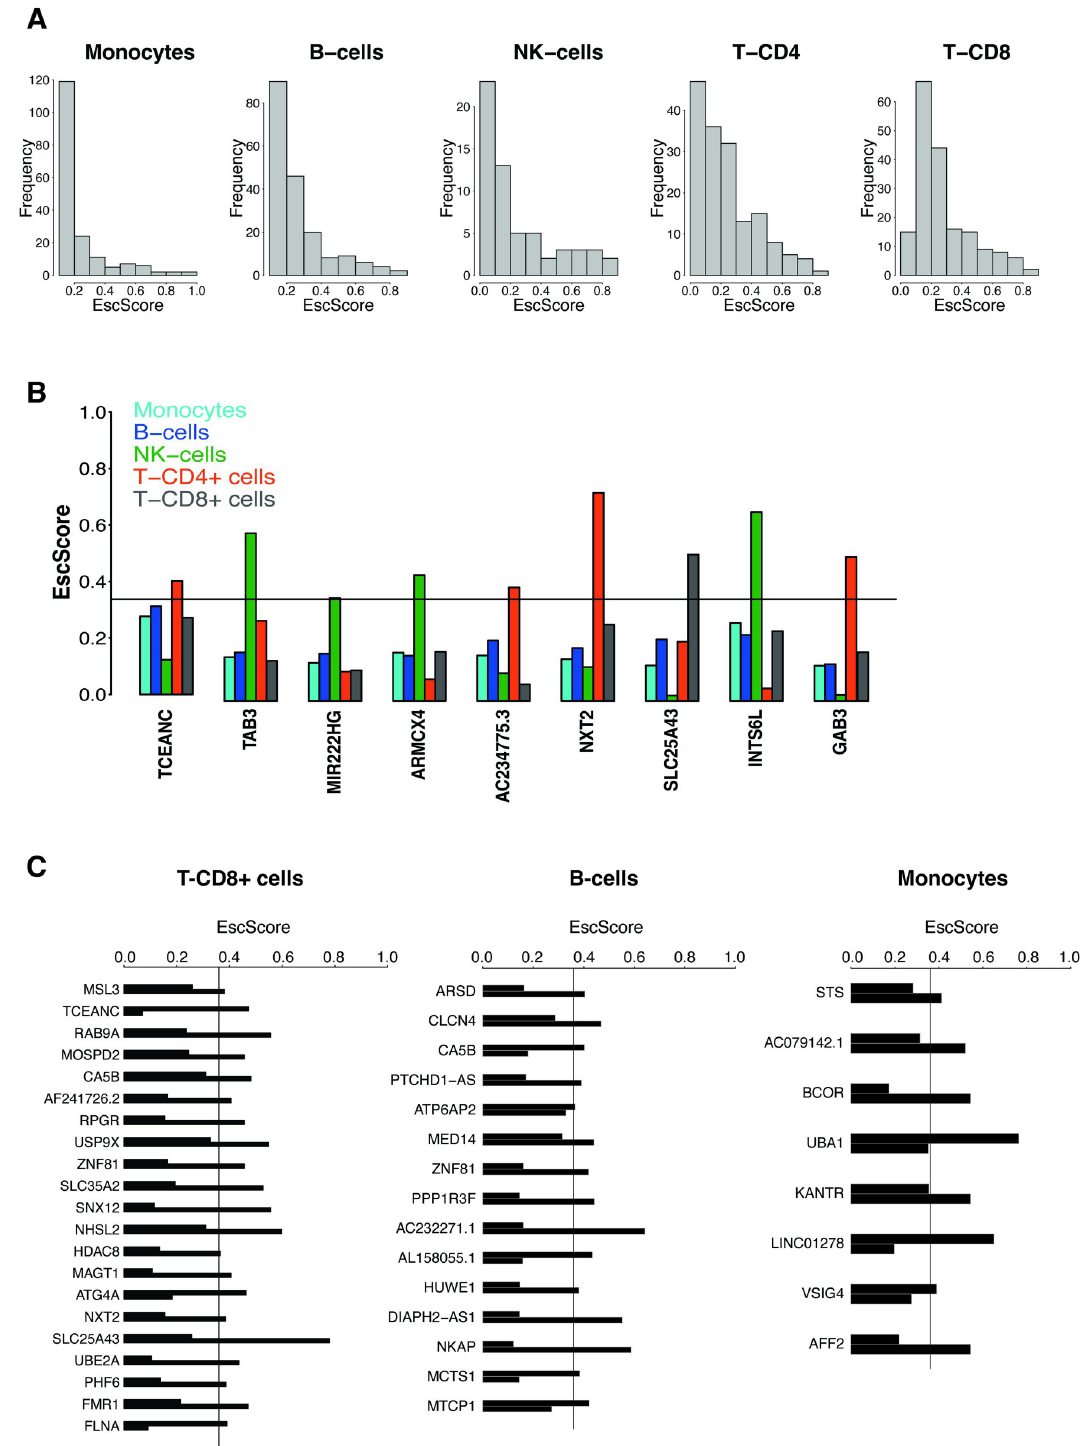
Fig 3. (A) Distribution of EscScore(s) in each immune cell type. (B) Genes exhibiting XCI escape restricted to a single immune cell type. Barplots show the immune cell type-specific gene’s EscScore. (C) Genes exhibiting discordant XCI status (escaping XCI only in one co-twin) between the two MZ co-twins. The two bars shows the gene’s EscScore in an immune cell type (T-CD8 + cells, B-cells and monocytes) in the two co-twins.